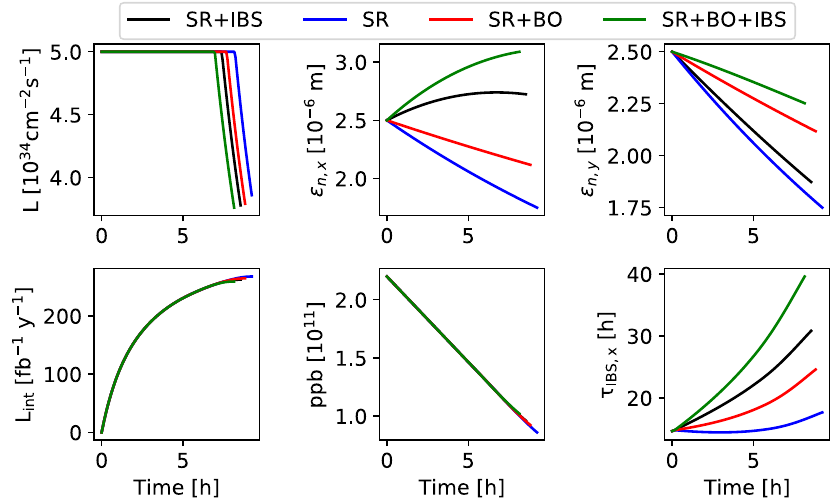
FIG. 7. Simulated physics for HL-LHC, including synchrotron radiation (SR), intrabeam scattering (IBS) or emittance growth due to burn-off